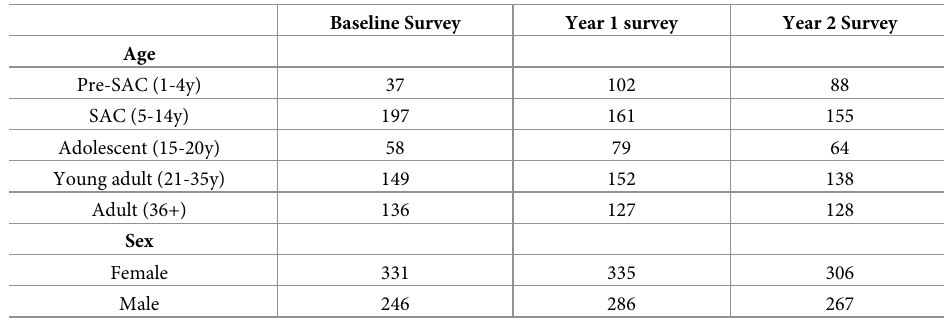
Table 1. Sample sizes in the three surveys stratified by age and